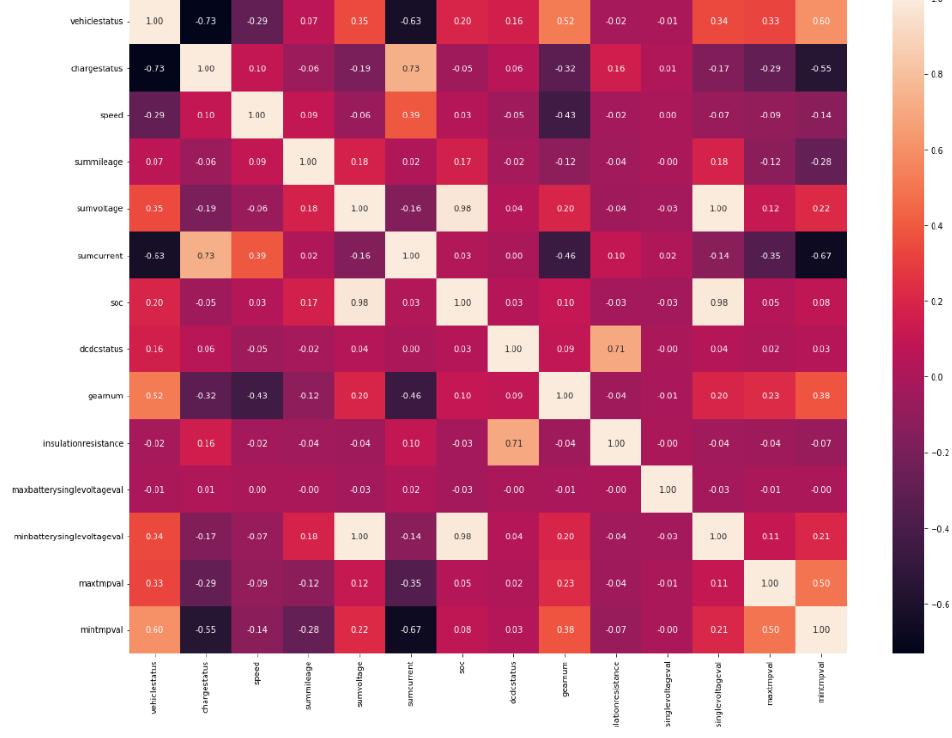
Figure 11. Heat map of each data of